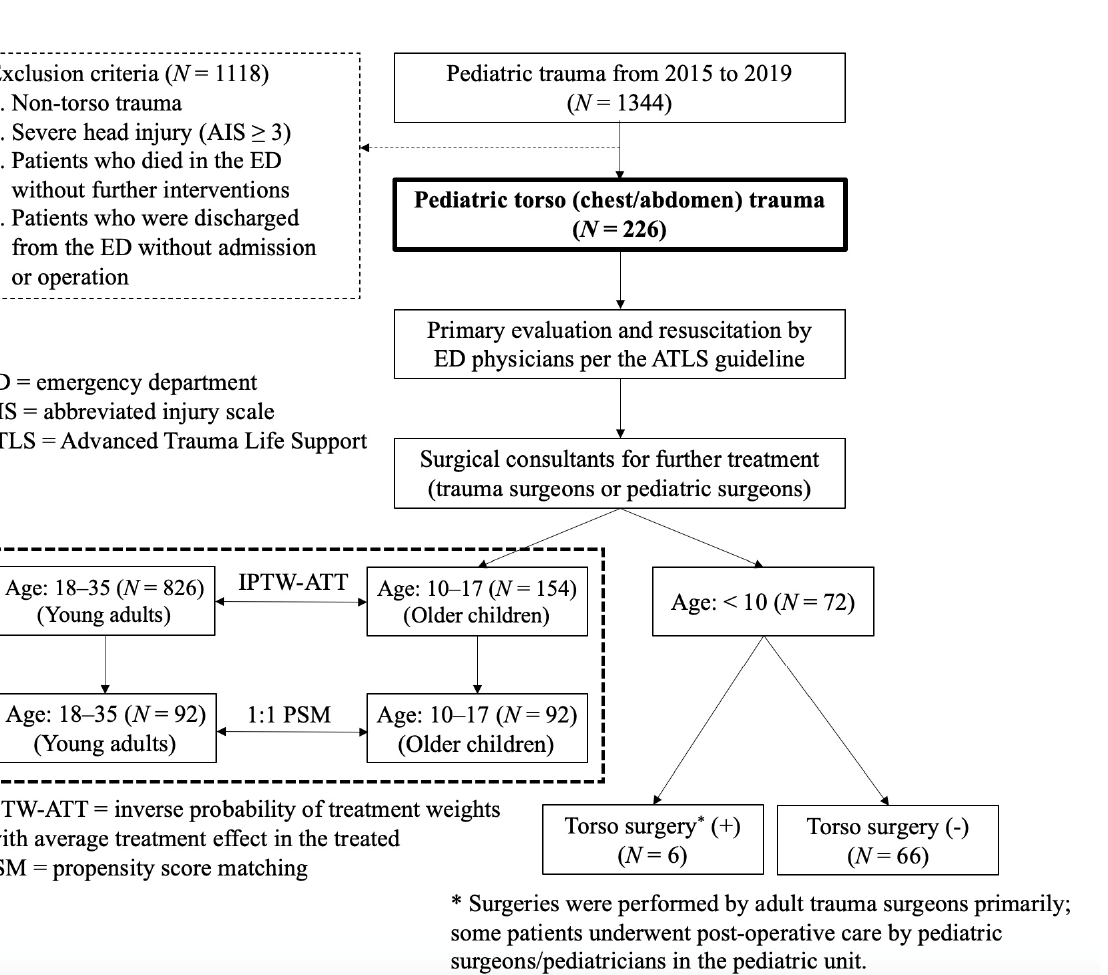
Figure 1. Patient distribution and study protocol of the current study.